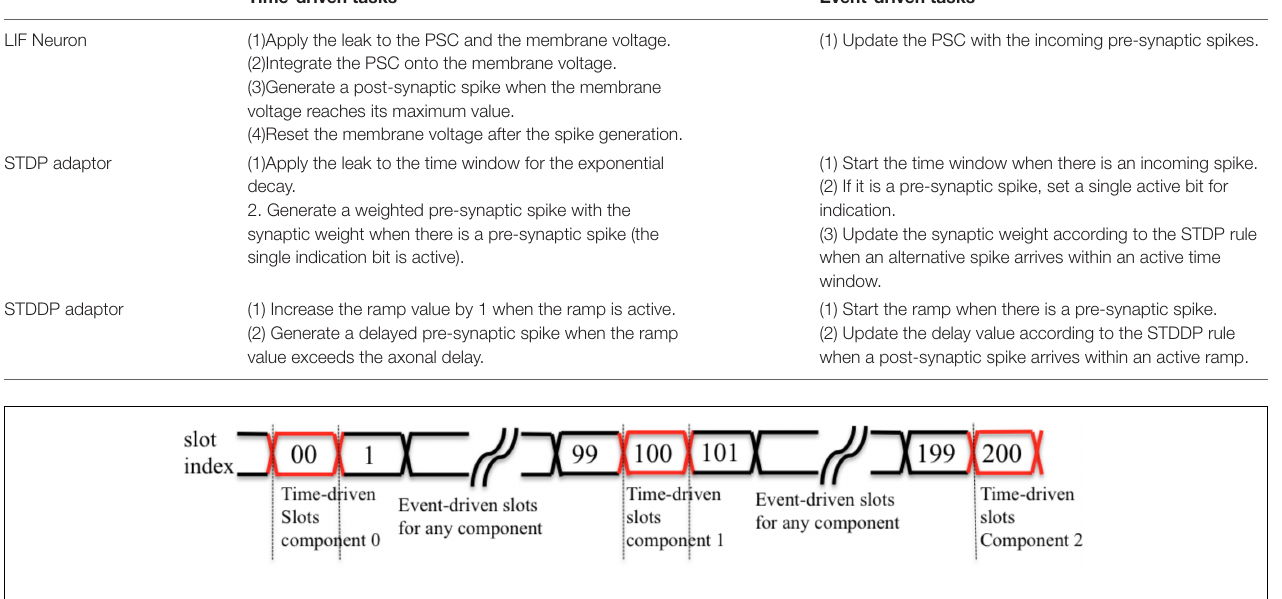
TABLE 2 | Functions of the physical component. Time-driven tasks Event-driven tasks